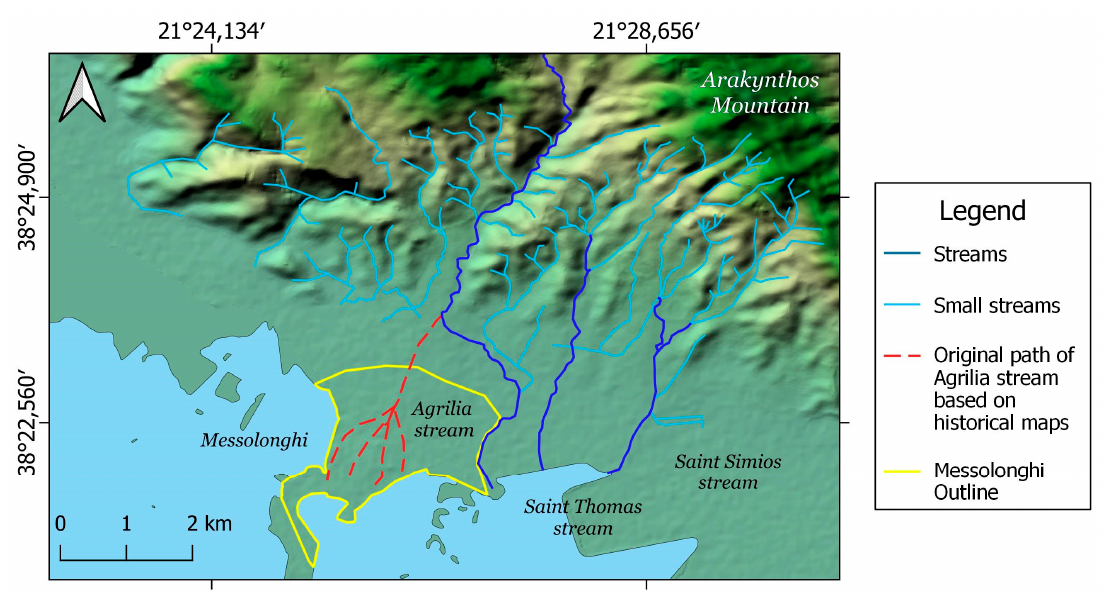
Figure 2. Hydrographical map of Messolonghi greater area.